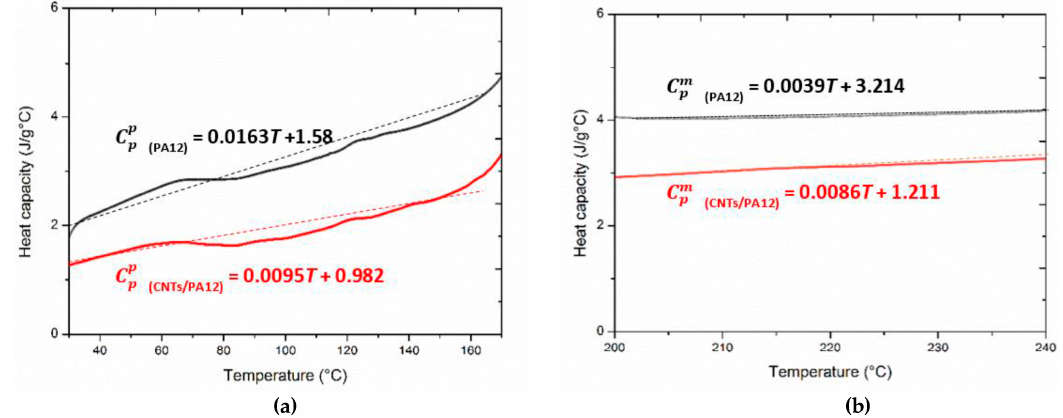
Figure 3. Specific heat of PA12 and CNTs/PA12 at ( a ) powder phase and ( b ) liquid phase.